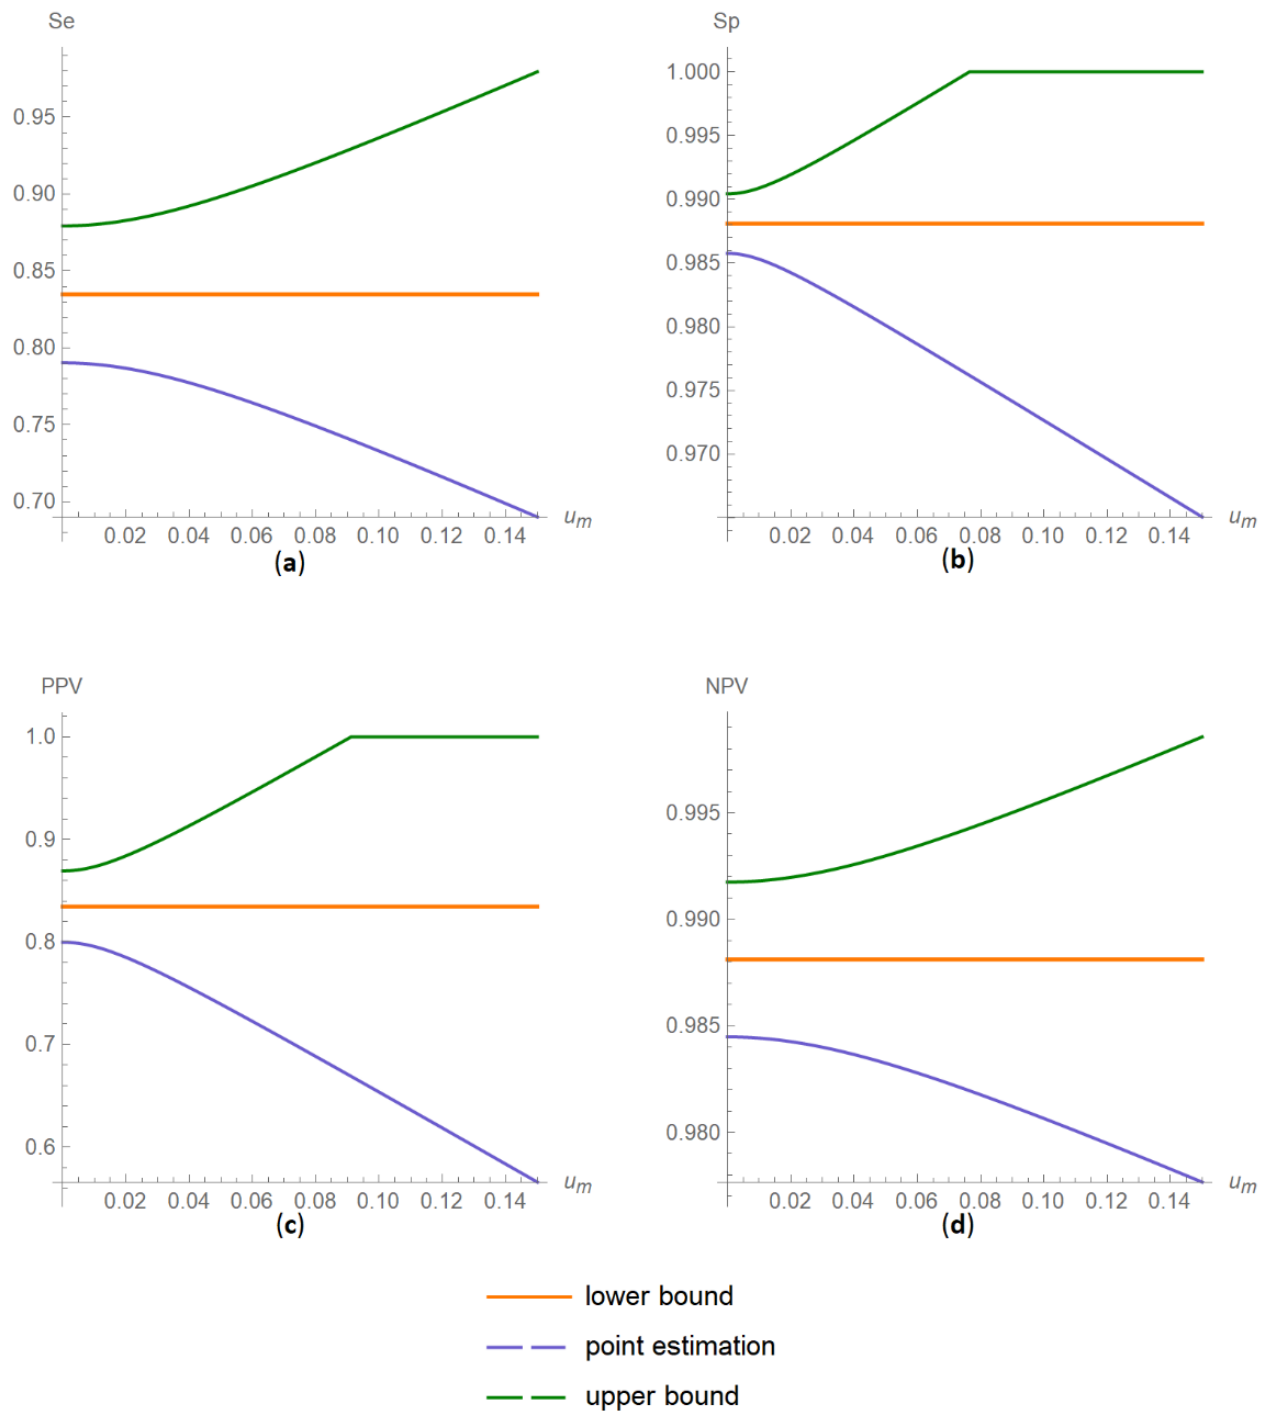
Figure 19. DAM relative standard uncertainties versus measurement uncertainty plots. Plots of relative standard combined, Figure 19. DAM confidence intervals versus measurement uncertainty plots. Plots of confidence intervals of ( a ) sensitivity measurement and sampling uncertainties of ( a ) sensitivity ( u ( Se )/ Se ), ( b ) specificity ( u ( Sp )/ Sp ), ( c ) positive predictive value ( Se ), ( b ) specificity ( Sp ), ( c ) positive predictive value ( PPV ) and ( d ) negative predictive value ( NPV ) versus standard meas- ( u ( PPV )/ PPV ) and ( d ) negative predictive value ( u ( NPV )/ NPV ) versus standard measurement uncertainty ( u m ) curves, urement uncertainty ( u m ) curves, with the respective parameter settings in Table 4. with the respective parameter settings in Table